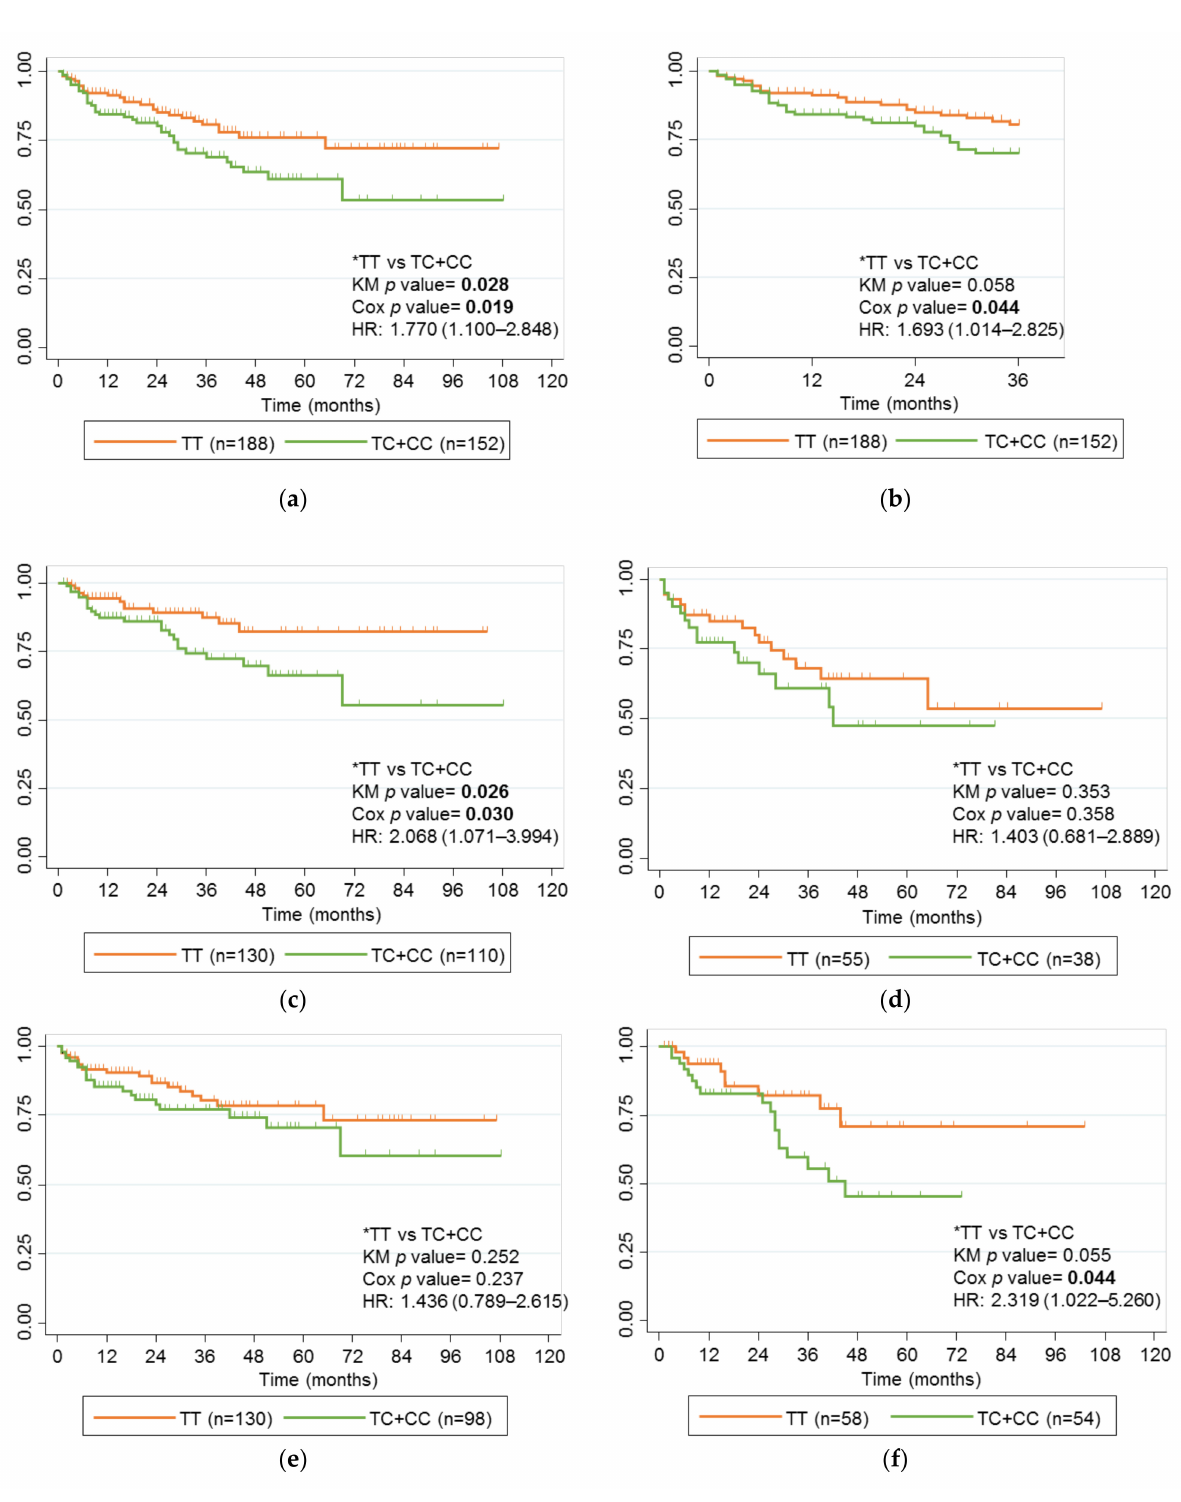
Figure 1. Kaplan-Meier curves for rs2097432 and failure of anti-TNF therapy. ( a ) Children with IBD treated with anti-TNF drugs; ( b ) Children with IBD treated with anti-TNF drugs for 36 months; ( c ) Children with CD treated with anti-TNF drugs; ( d ) Children with UC treated with anti-TNF drugs; ( e ) Children with IBD treated with IFX; ( f ) Children with IBD treated with ADL. Genotype comparisons and p values for the univariate analysis (KM p value) and multivariate analysis (Cox p value) analyses are presented alongside Kaplan-Meier curves. Significant p values are marked in bold. * Reference